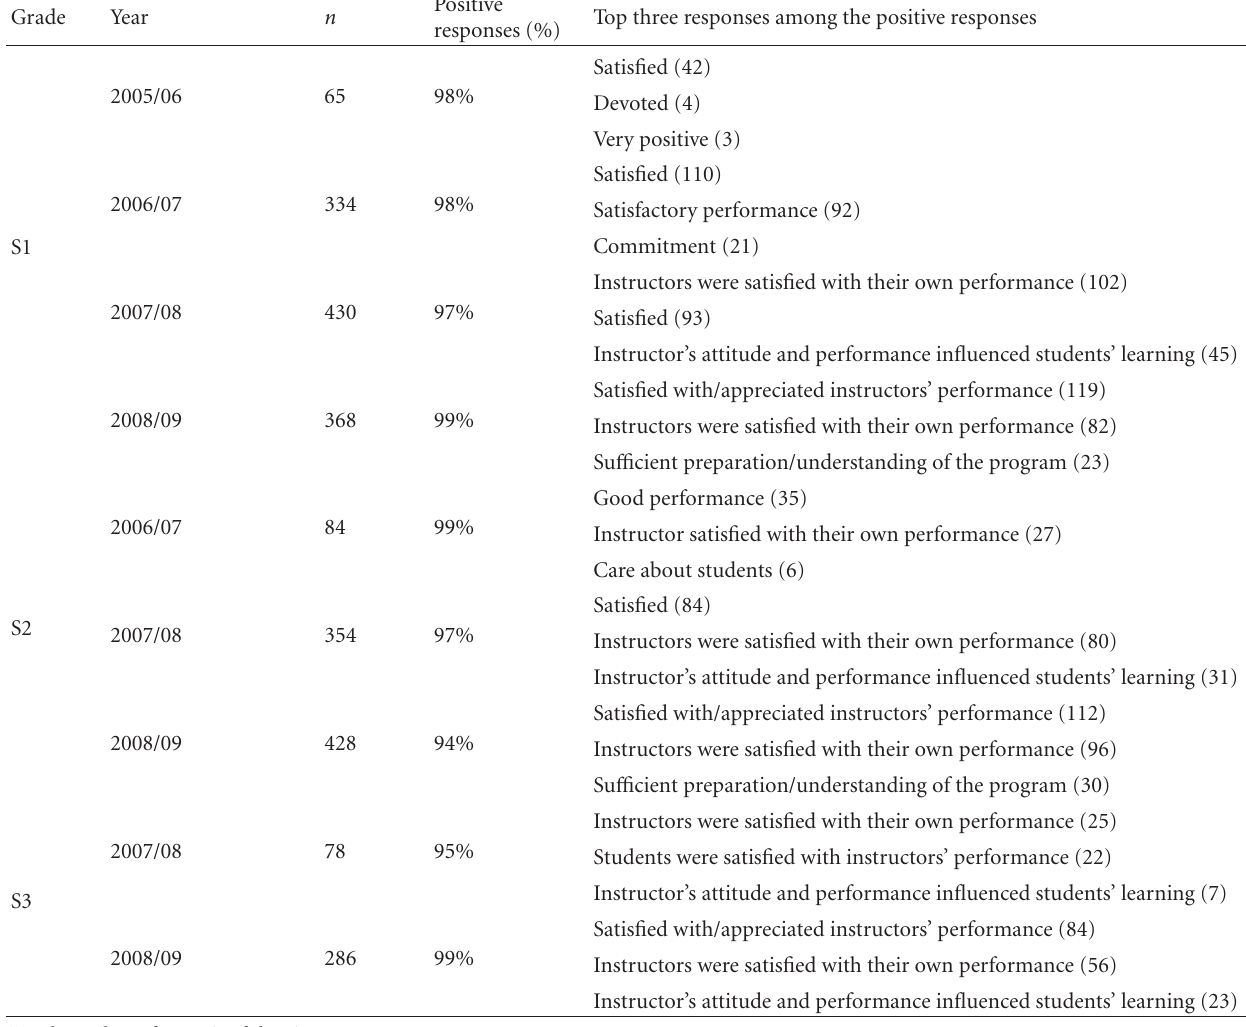
Table 3: Responses on Views toward Program Implementers in Di ff erent